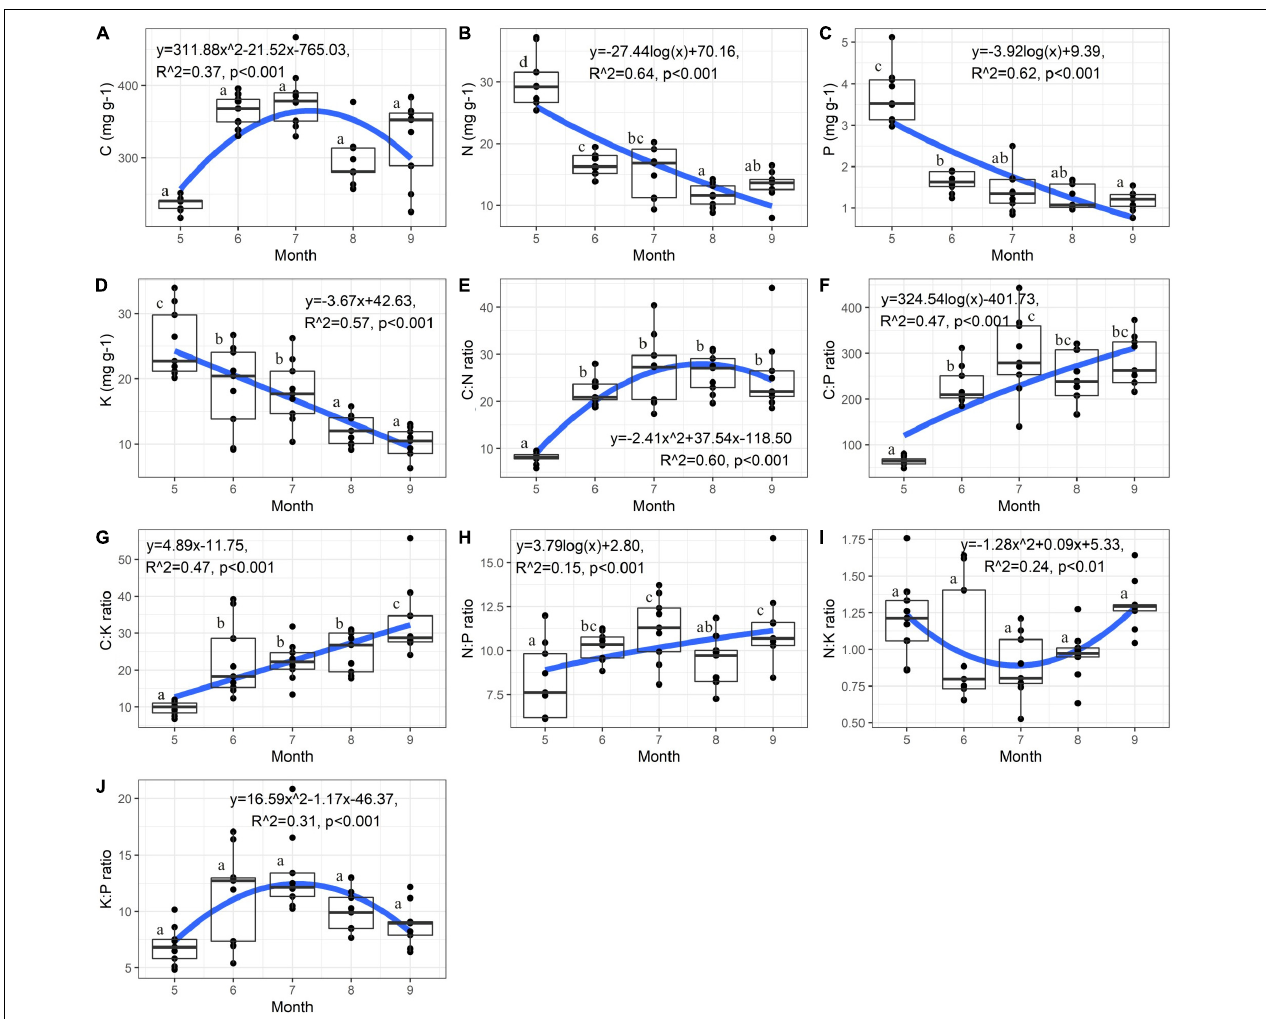
FIGURE 2 | Variation of nutrient stoichiometry of Carex schmidtii at the entire growth stages. (A) C concentration, (B) N concentration, (C) P concentration, (D) K concentration, (E) C:N ratio, (F) C:P ratio, (G) C:K ratio, (H) N:P ratio, (I) N:K ratio, and (J) K:P ratio. Fitting was applied to describe the dynamic of nutrient. NW, Natural tussock wetland; RW, Restored tussock wetland; DW, Degraded tussock wetland.